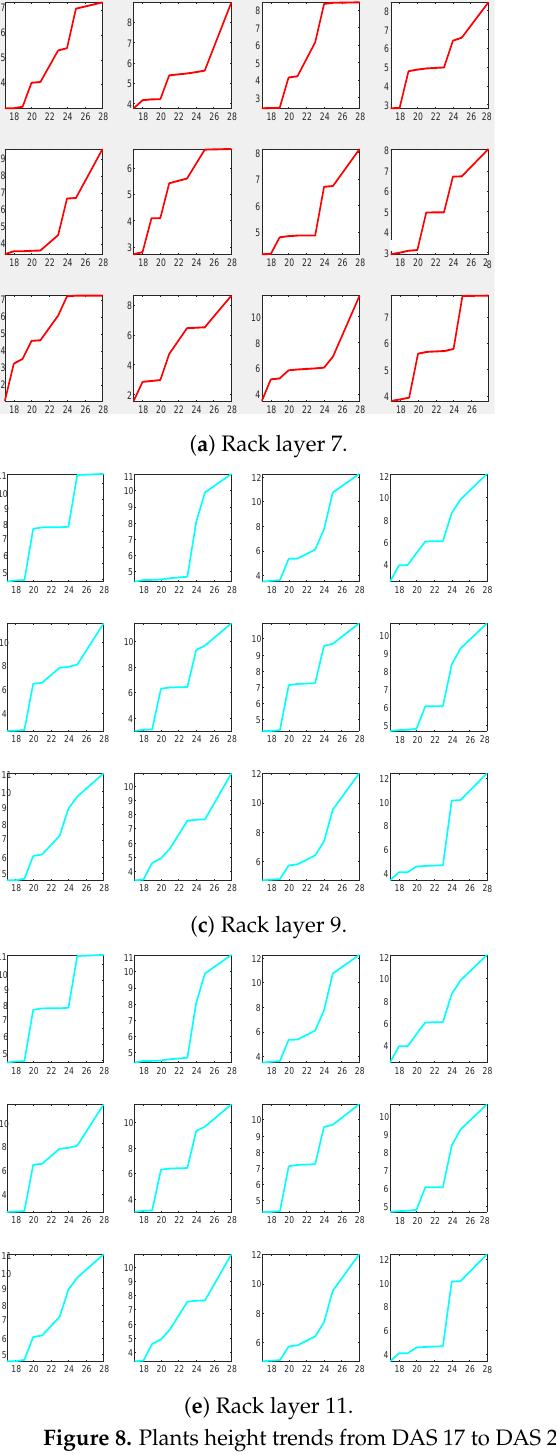
( a ) Rack layer 7. ( b ) Rack layer 8.